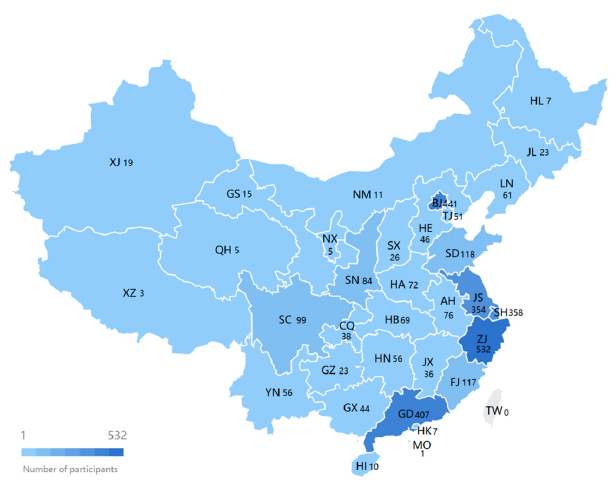
Figure 1. Distribution of participants.